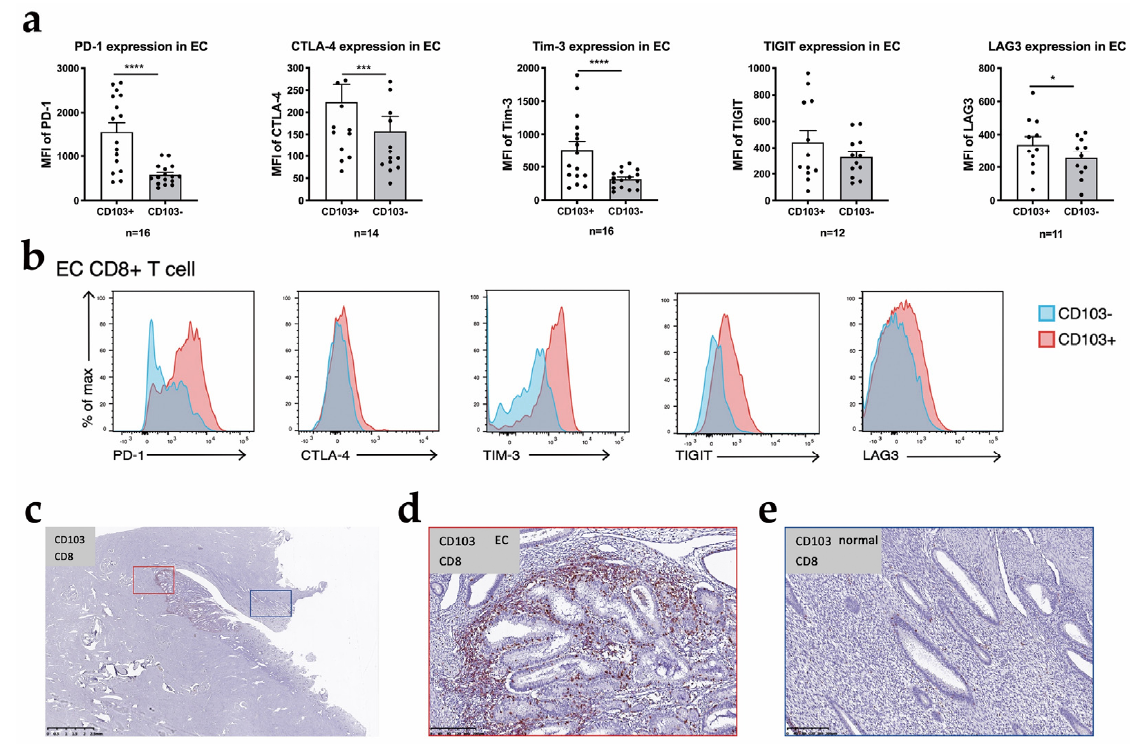
Figure 5. The expression levels of immune checkpoints in T RM cell: ( a ) The expression levels of PD-1, CTLA4, Tim-3 and LAG3 were significantly increased in CD103+ CD8+ T cells; ( b ) One sample of the expression of PD-1, CTLA4, Tim-3 and LAG3 between CD103+ CD8+ T cells and CD103 − CD8+ T cells. ( c ) The distribution of CD103+ CD8+ cells detected using double immunohistochemical staining in a whole-slide red box: EC, blue box: normal. Partial magnification of ( d ) EC tumor tissue and ( e ) Adjacent normal endometrium. CD8+: red; CD103+: brown. p value compares the indicated group using an unpaired t-test (two-tailed). p < 0.05 (*), p < 0.001 (***), p < 0.0001